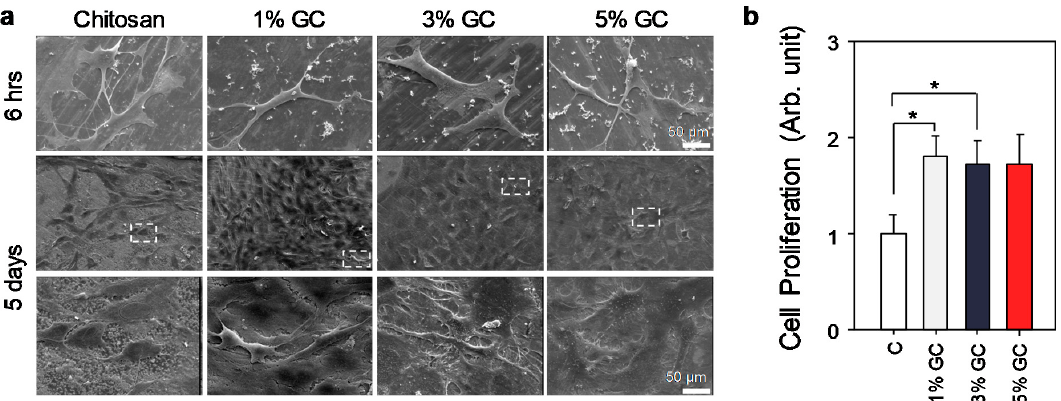
Figure 3. Effects of graphene–chitosan hybrid implants on the activity of mammalian cells. ( a ) Representative scanning electron microscope (SEM) images of MC3T3-E1 cells on graphene–chitosan hybrid implants (1%, 3%, and 5% GC) and the chitosan (C) implant. ( b ) Quantification of the cell proliferation of MC3T3-E1 cells ( n = 4 per group). The data were analyzed using one-way ANOVA and Tukey’s test (* p < 0.05).